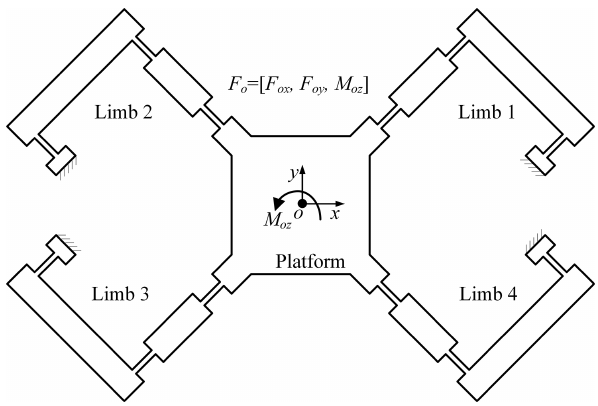
Figure 7. 4-RRR flexure-based compliant micro-motion